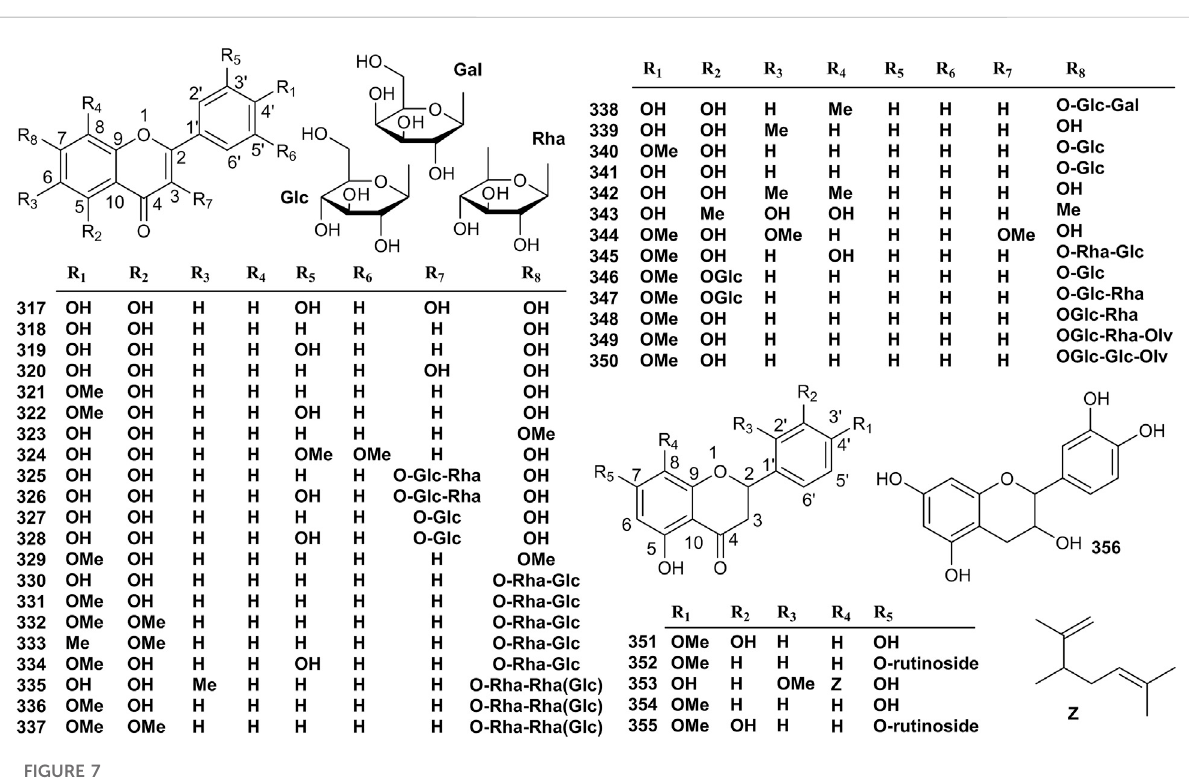
FIGURE 7 Structures of fl avonoids from the genus Valeriana